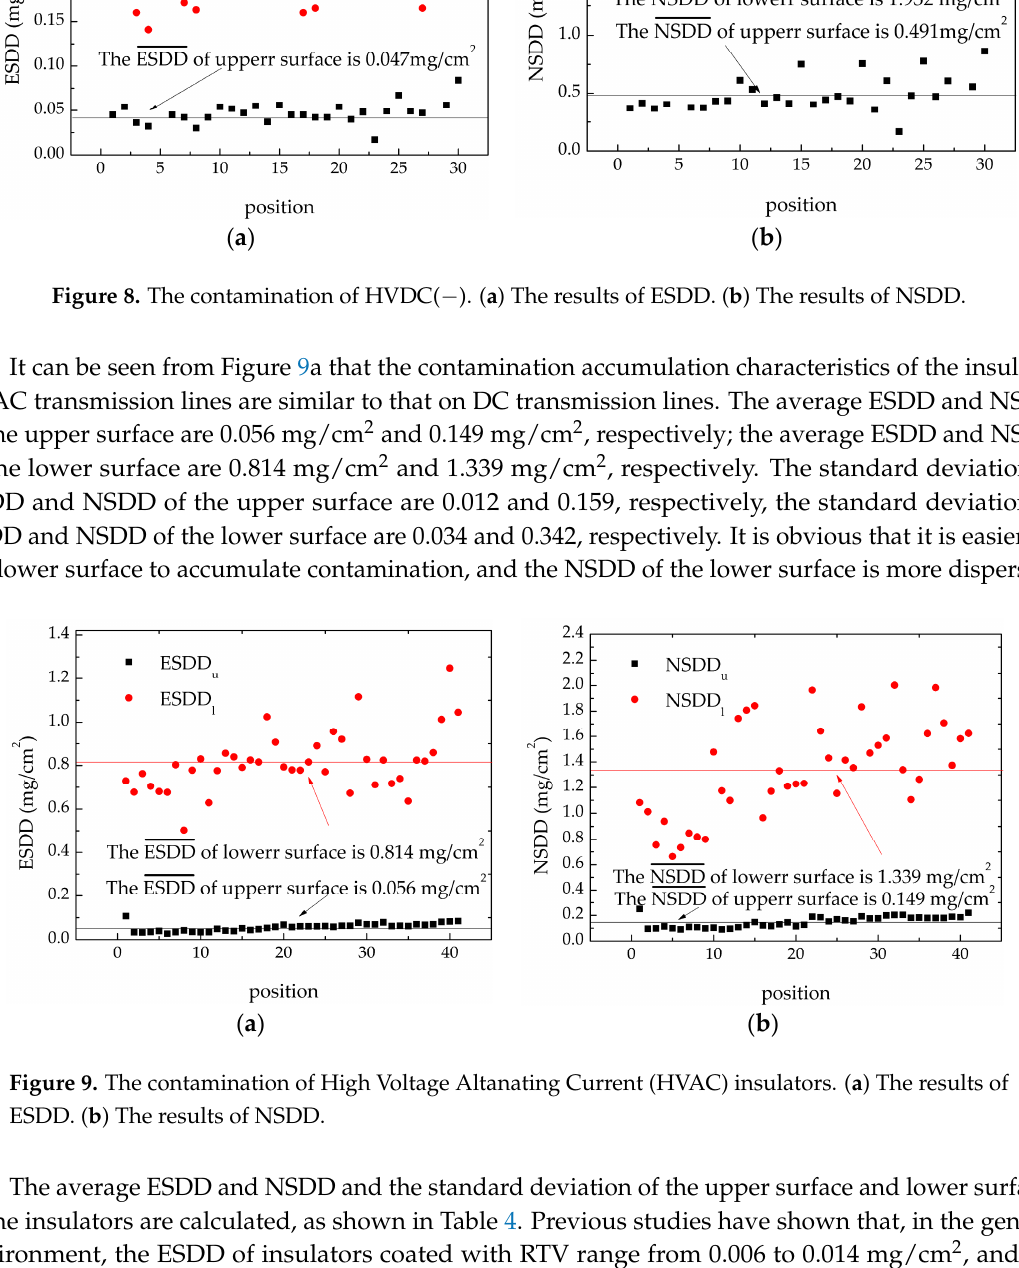
Table 4. The ESDD and NSDD of insulators. Voltage Type